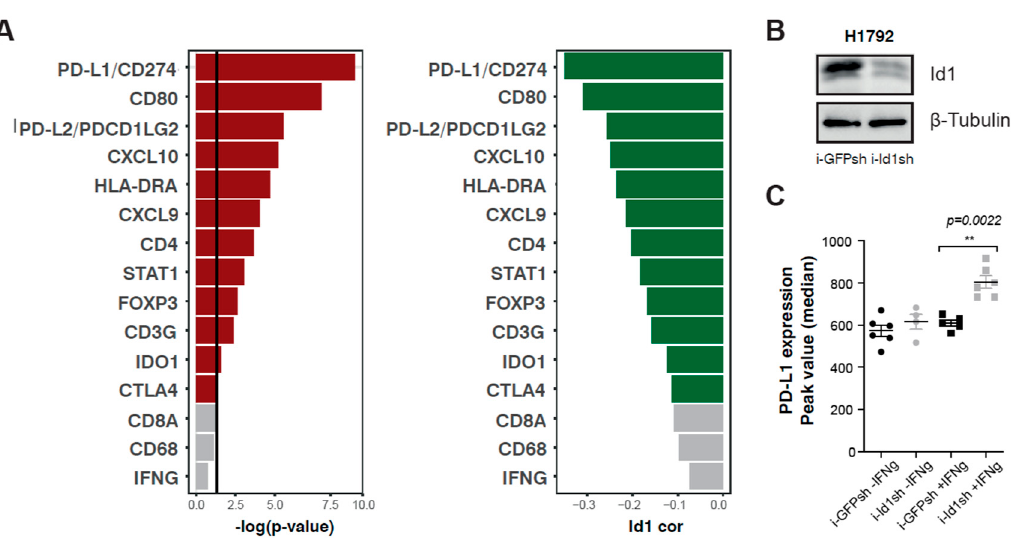
Figure 1. Id1 expression inversely correlates with the mRNA expression levels of several markers related to immune response. ( A ) Pearson correlation coe ffi cients (green) and p -values (red) between Id1 mRNA expression levels and di ff erent genes associated with the immune system in LUAD patients. ( B ) Western blot for detection of Id1 protein in human H1792 cells infected with doxycycline-inducible shRNA lentiviral particles that target Id1 , in comparison with the same cell lines infected with a control i-GFPsh. ( C ) Flow cytometry analysis showed a statistically significant increase in PD-L1 expression after exposure to IFN- γ for 24 hours when human H1792 tumor cells had Id1 inhibited (Median of peak value: H1792 + IFN- γ : i-GFPsh 610.0 [579.5–641.5], i-Id1sh 790.5 [734.0–874.5], p = 0.0022). The data are reported as the median with the interquartile range. ** p < 0.01.